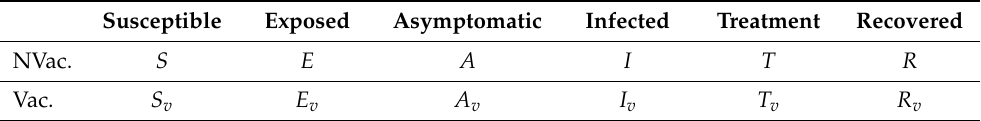
Table 1. Notation of compartments associated with the mathematical model (NVac. = Not vaccinated, Vac =